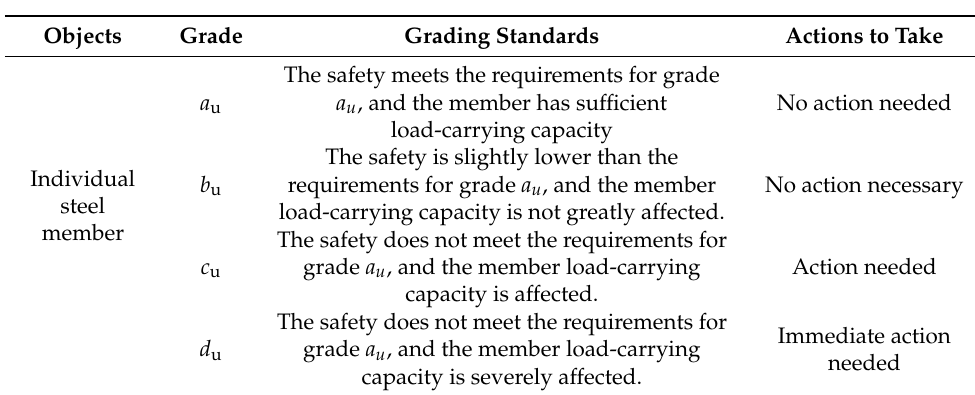
Table 7. Safety grading standards.